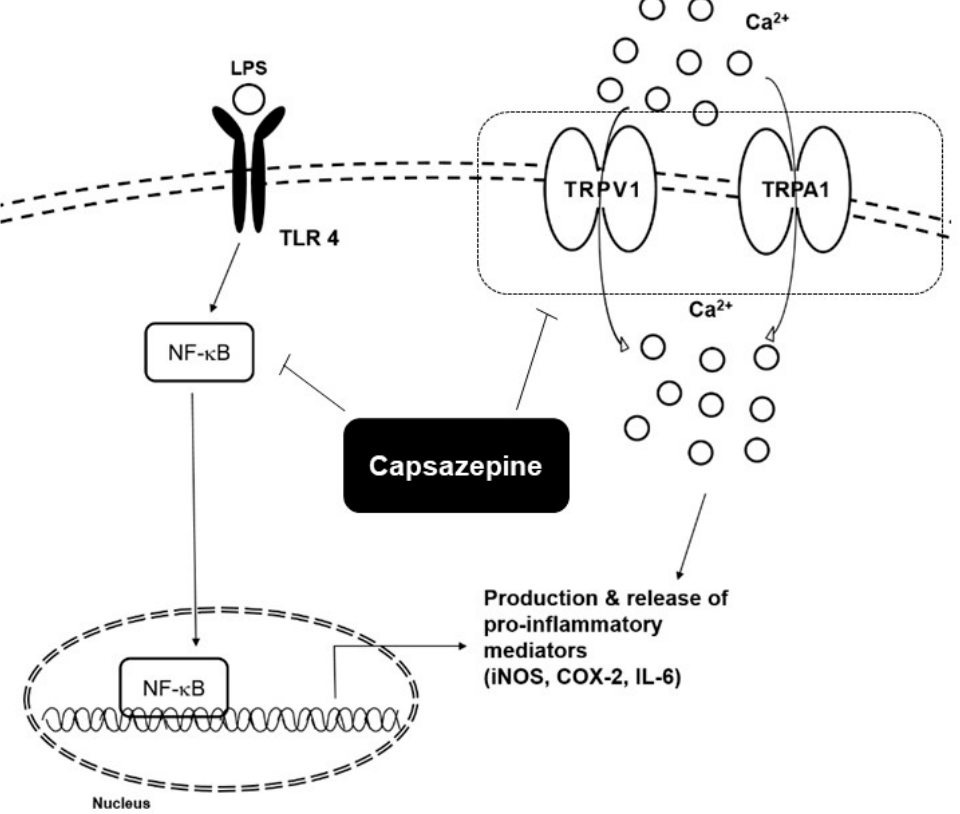
Figure 4. Potential mechanisms regulating anti-inflammatory effects of capsazepine. Table 3. Anti-inflammatory Effects of capsazepine in vitro.